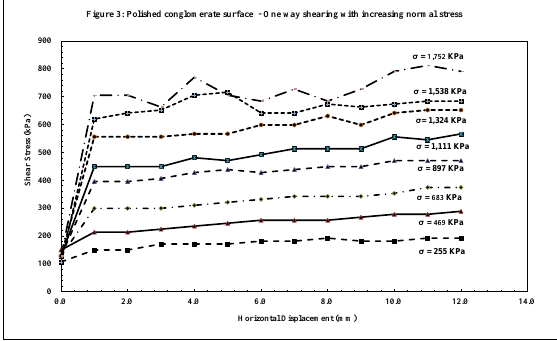
Figure 3: Polished conglomerate surface -One way shearing with increasing normal